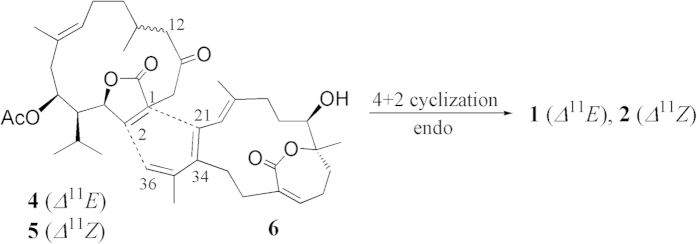
Plausible Diels-Alder reaction to derive compounds 1 and 2.